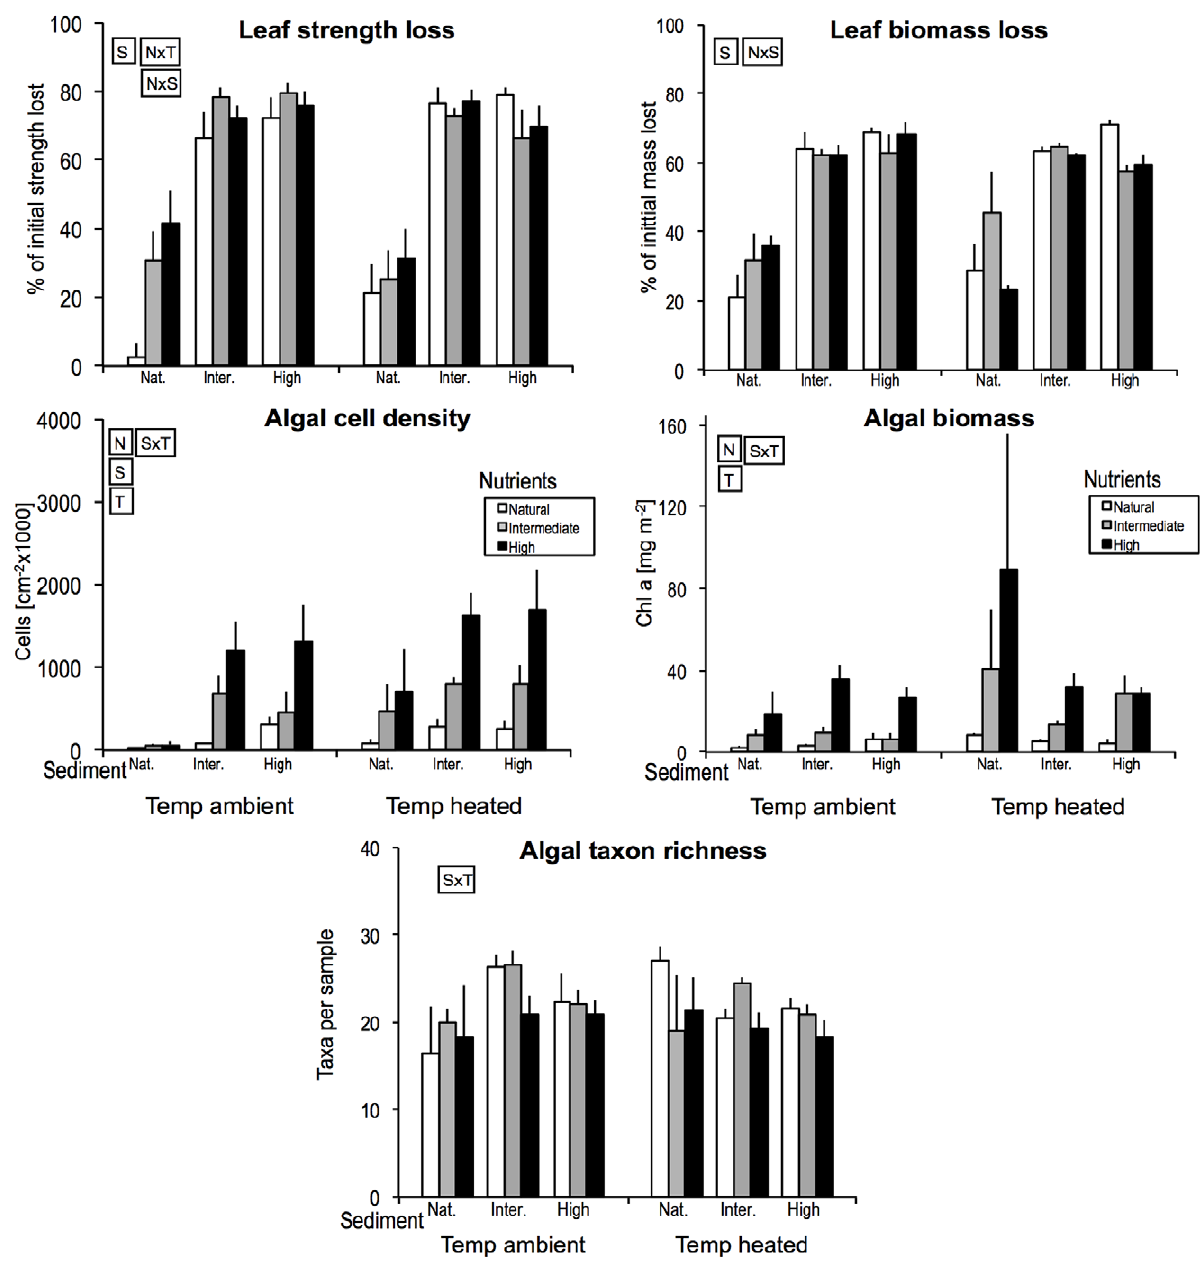
Figure 3. Averages of leaf decay variables (sampled on day 18) and algal community/biomass variables (sampled on day 29) across the experimental treatments. For more details see Fig.